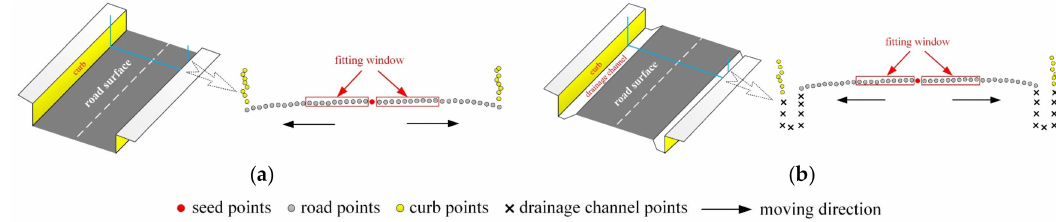
Figure 3. Two typical types of road surfaces: ( a ) Road surfaces I; ( b ) road surfaces II. The crosses are drainage channel points that have not been